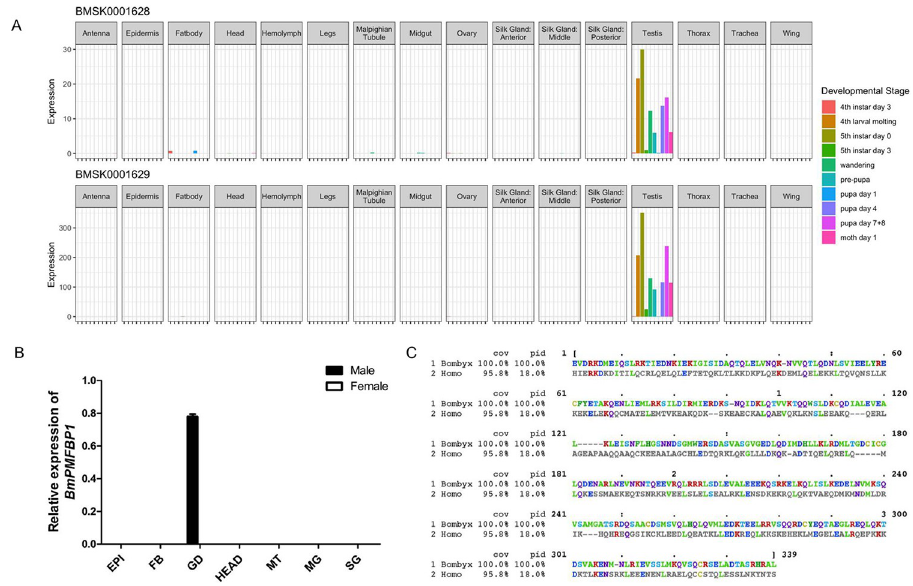
Fig 1. BmPMFBP1 is specifically expressed in testes. (A) Tissue and developmental stage-specific levels of gene expression for two SilkDB3 annotations corresponding to the BmPMFBP1 locus. (B) The relative transcript level of BmPMFBP1 in various tissues from the fourth day of the fifth larval instar (L5D4). Tissues including epidermis (EP), fat body (FB), gonad (GD, testes in male and ovary in female), head (HE), midgut (MG), Malpighian tubule (MT), silk gland (SG). (C) HMM (hidden Markov model) profile alignment of the SMC domain in PMFBP1 from human ( Homo ) and silkworm ( Bombyx ). Protein regions outside of those represented here failed to